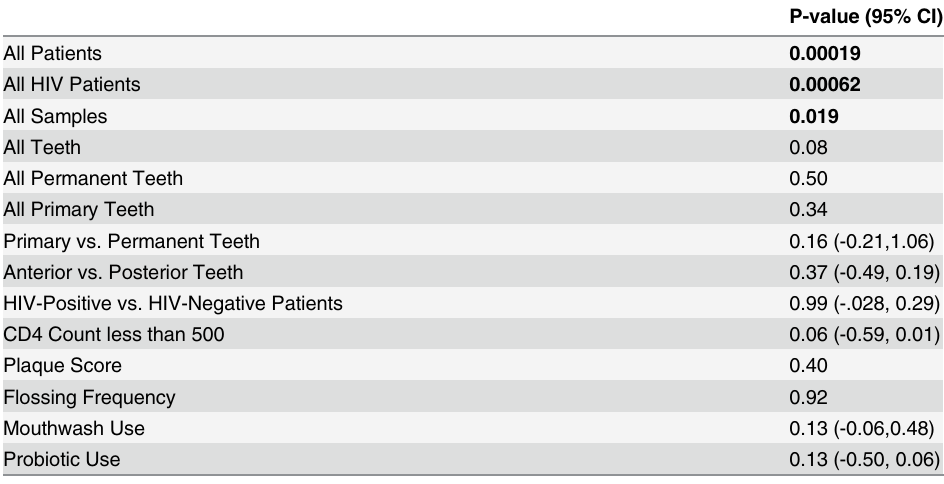
Table 6. Shannon Diversity Scores a